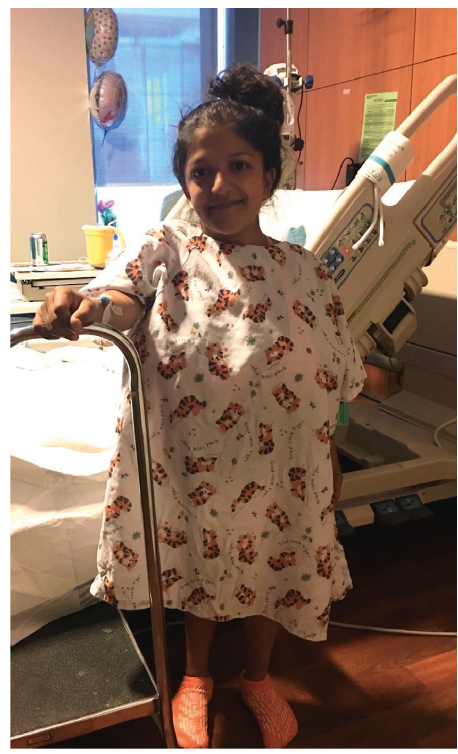
Figure 1: Fanconi–Bickel syndrome patients demonstrate char- acteristic short stature.